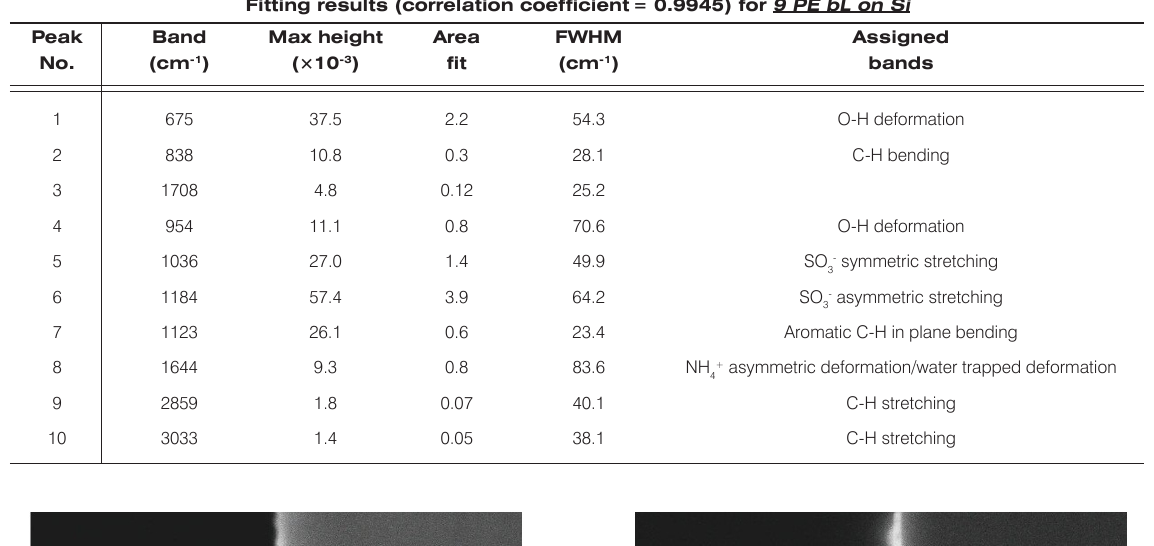
Table 2. Peak assignments for polyelectrolyte multilayer structure builded-up on the Si surface. Fitting results (correlation coefficient = 0.9945) for 9 PE bL on Si Peak